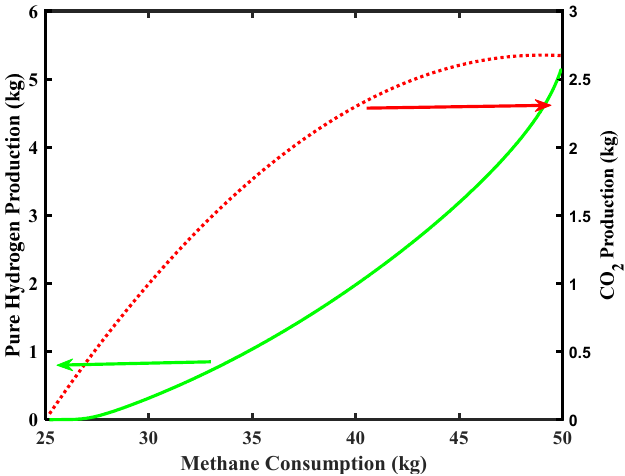
Figure 8. CO 2 and pure H 2 productions versus CH 4 consumption for Pd-Ag membrane thickness = 50 µm and water to methane ratio= 2.5, inlet temperature = 500 °C, and inlet pressure = 10 bar.